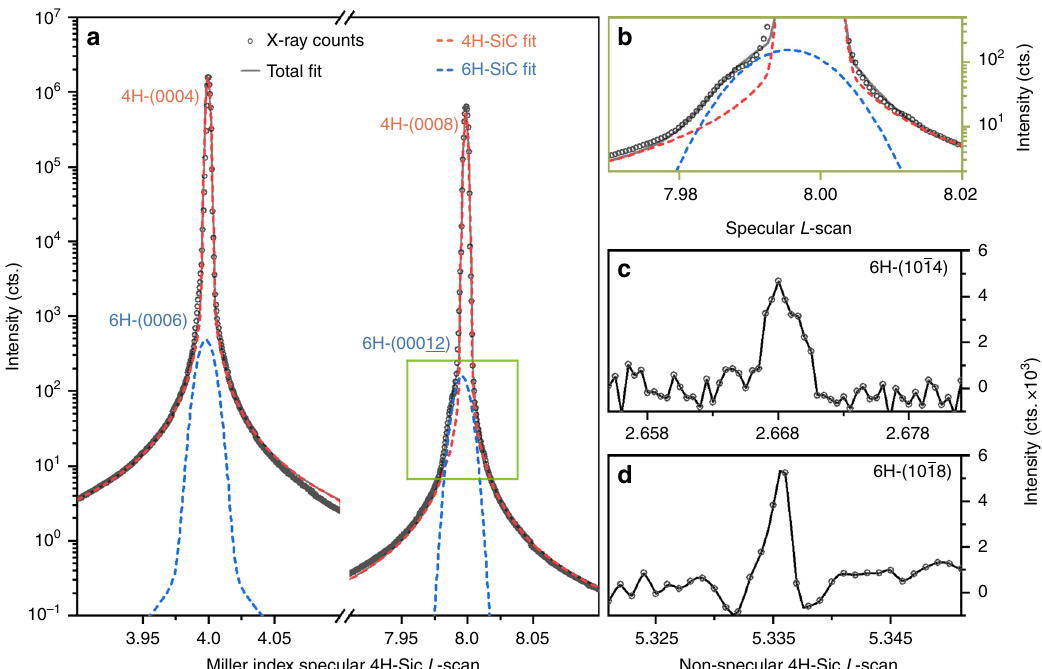
Fig. 4 X-ray diffraction studies of polytype inclusions in 4H-SiC. a Shows the (0004)/(0008) L-scan of 4H-SiC and contributions of the detected (0006)/(00012) contributions from 6H-SiC. We note the 4H and 6H components fi tted simultaneously as fully inter-related doublets. b Zoom-in of the 4H- (0008) diffraction peak skew due to the presence of 6H-SiC polytypic inclusions. c and d The non-specular ð 10 (cid:1) 14 Þ and ð 10 (cid:1) 18 Þ peaks of 6H, 12 ID-D of the Advanced Photon Source (APS) (see the “ Methods ” section for technical details). Crystallographically, 1FSF(3,2) Frank-type stacking faults are synonymous with the